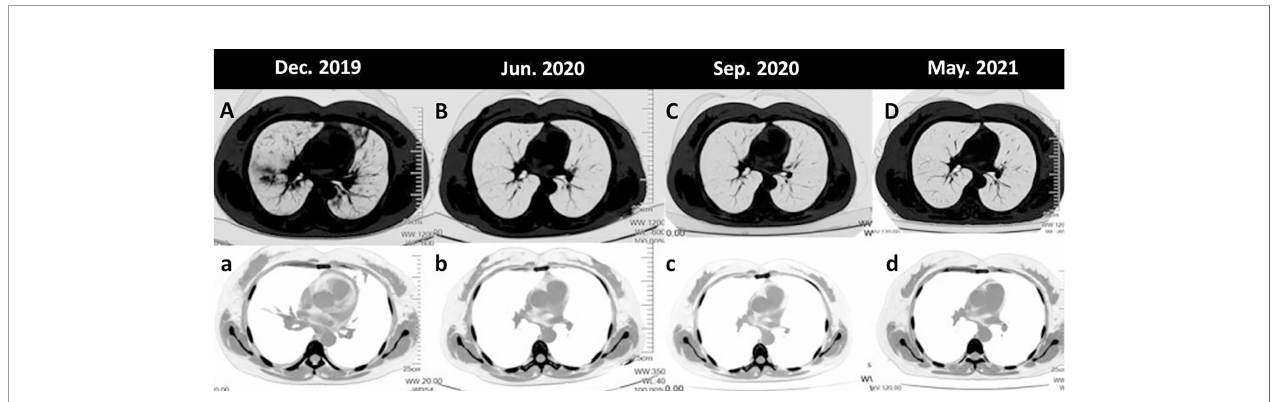
FIGURE 1 | Dynamic chest computed tomography scans of the patient during treatment. Multiple nodules and patches in both lungs with blue arrow. (A) At initial diagnosis. (B) Six-months after initiation of crizotinib, remarkable reduction of multiple nodules and patches in both lungs, and improvement of mediastinal lymphadenopathy. (C) At 3 months of ceritinib treatment. (D) At 11 months after ceritinib